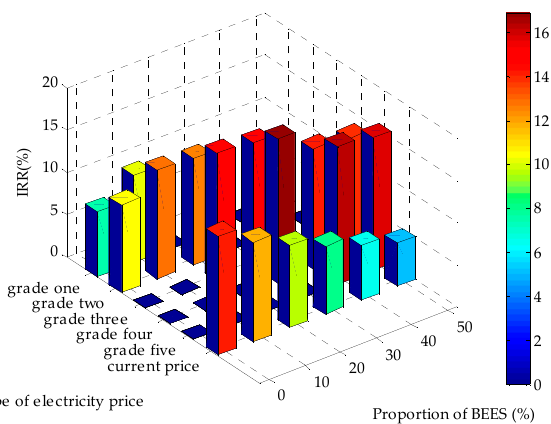
Figure 12. The comparison of the IRR with the three-part electricity price and the current stake electrovalence.